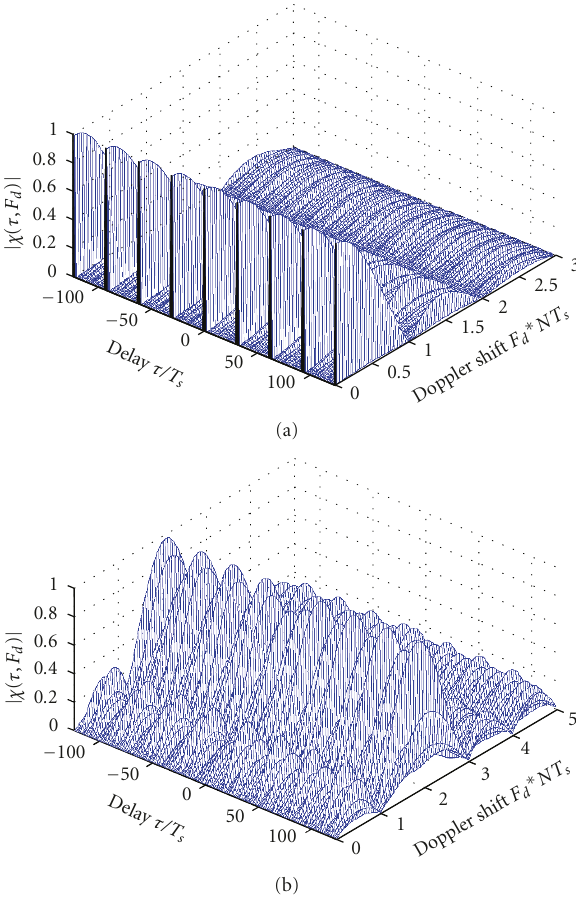
Figure 3: Ambiguity function of 124-length ZCZPS: (a) autocorre- lation, (b) cross-correlation.